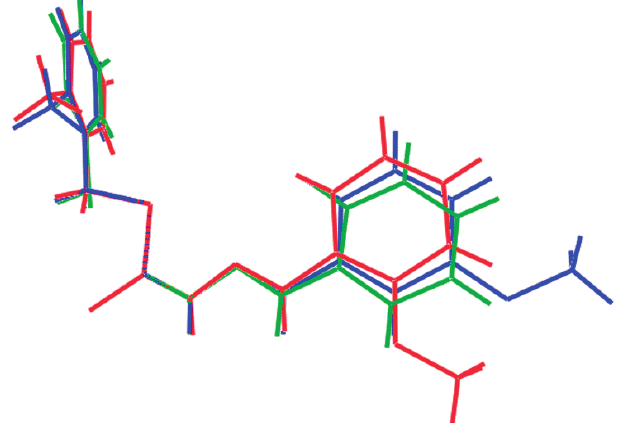
Figure 3. Overlay diagram of the molecular structures of 1 (red image), 2 (blue) and the unsubstituted parent compound (green) with the CS 2 residues